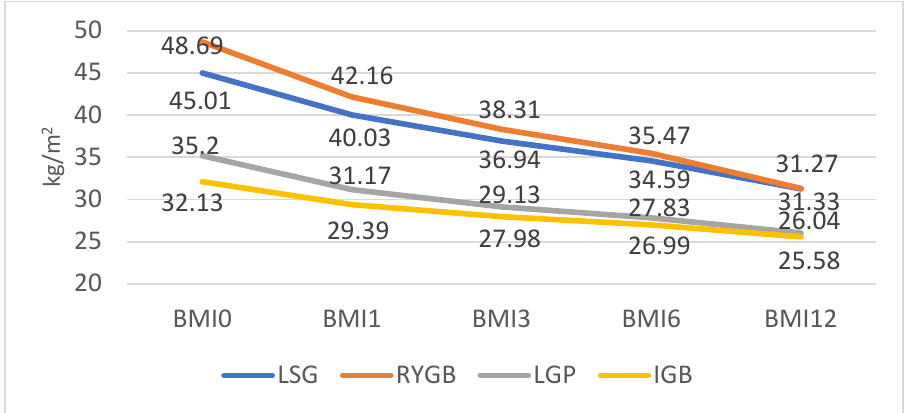
Figure 3. Mean BMI during the 1, 3, 6 and 12 ‐ month follow ‐ ups.